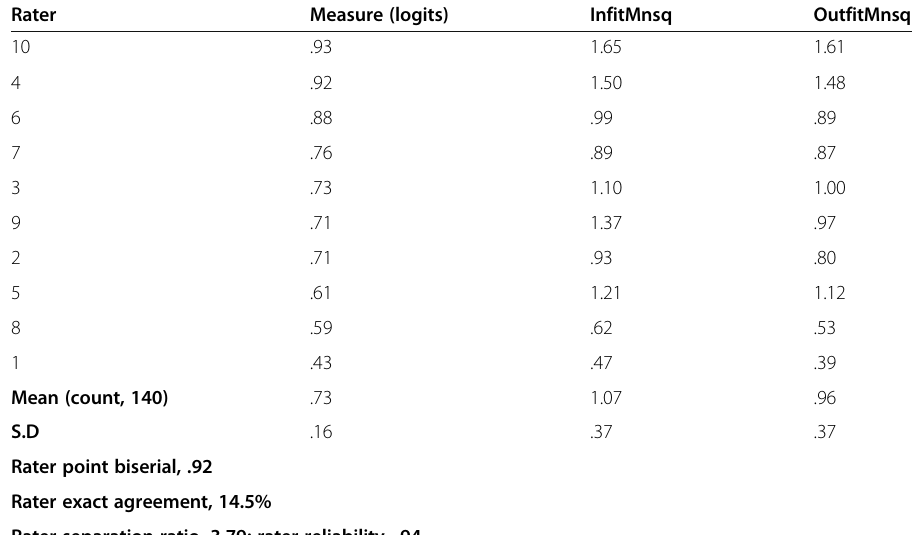
Table 2 Rater measurement report — whole scale